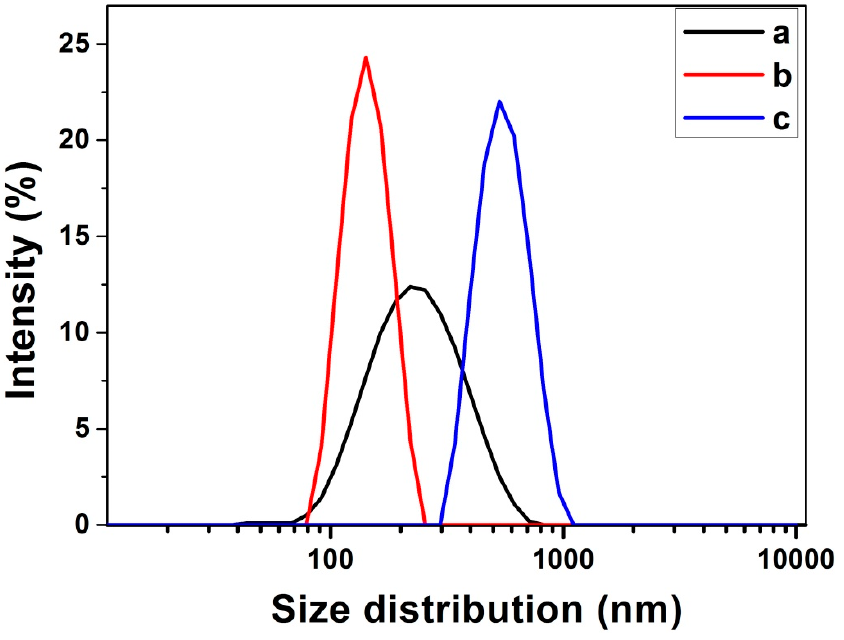
Figure 4. Size distribution of Fe 3 O 4 @LNPs prepared by ( a ) L 1 : 0.5 mg/mL, ( b ) L 2 : 1.0 mg/mL, and ( c ) L 3 : 5mg/mL lignin.